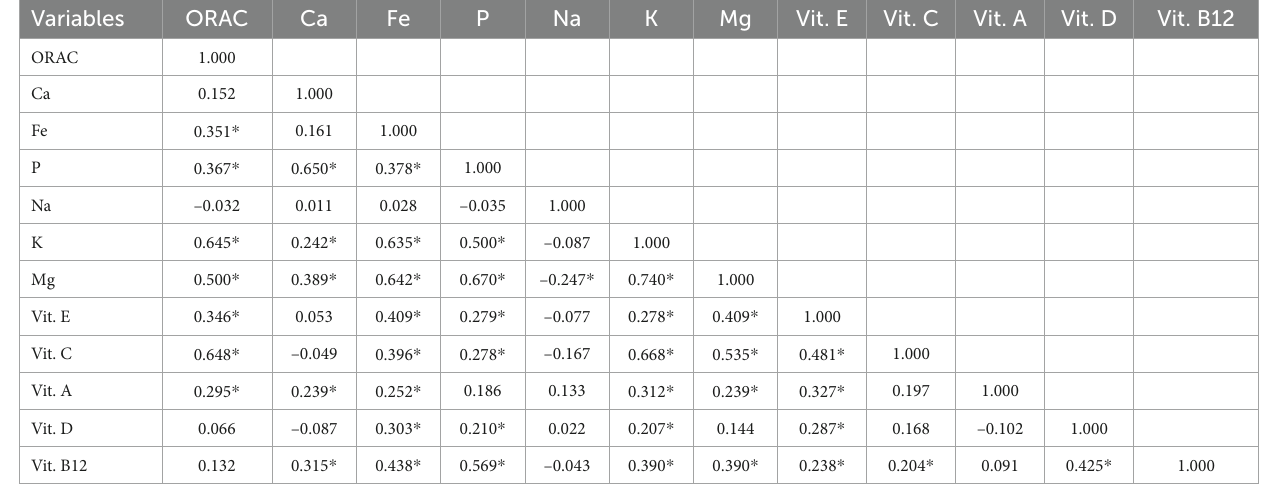
TABLE 3 Spearman’s rank correlation